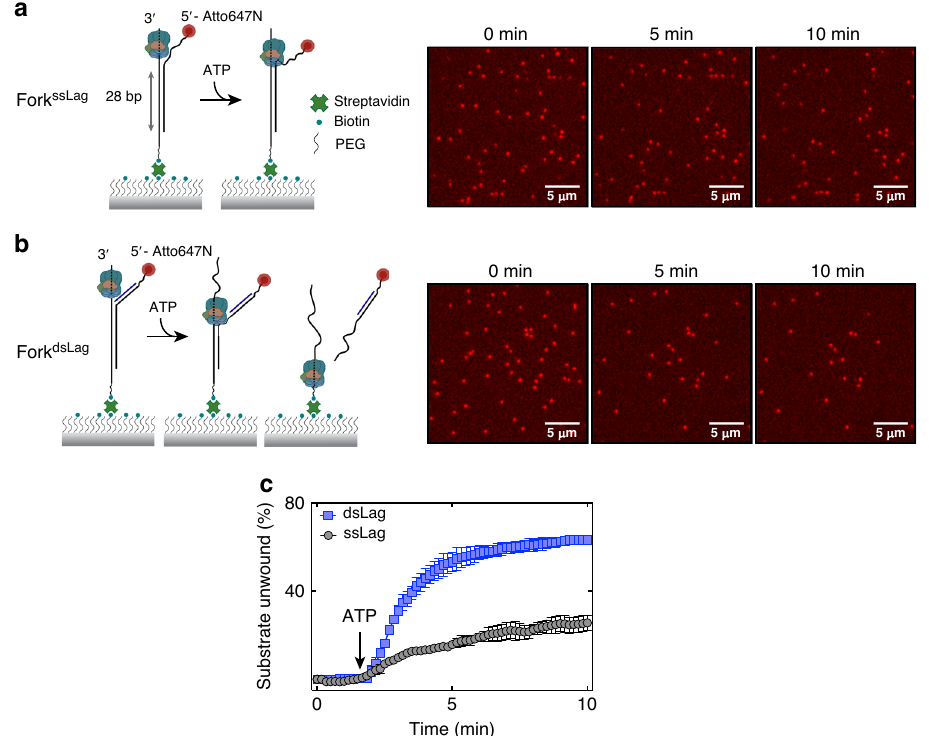
Fig. 4 Single-molecule analysis of CMG-catalyzed fork unwinding. a , b Visualizing CMG-driven unwinding of individual Atto647N-labeled surface- immobilized fork substrates with TIRF microscopy. Unwinding of 28-bp duplex region by CMG leads to dissociation of the fl uorescent strand from the surface. Representative fi elds of view are shown at three time points on Fork ssLag a and Fork dsLag b following ATP addition ( n = 3 independent experiments). c Percentage of molecules unwound as a function of time for Fork ssLag (gray, N = 1215 molecules from n = 3 independent experiments) and Fork dsLag (blue, N = 1611 molecules analyzed). Data represent mean ± SD from three independent experiments for each substrate. Source data are provided as a Source Data fi